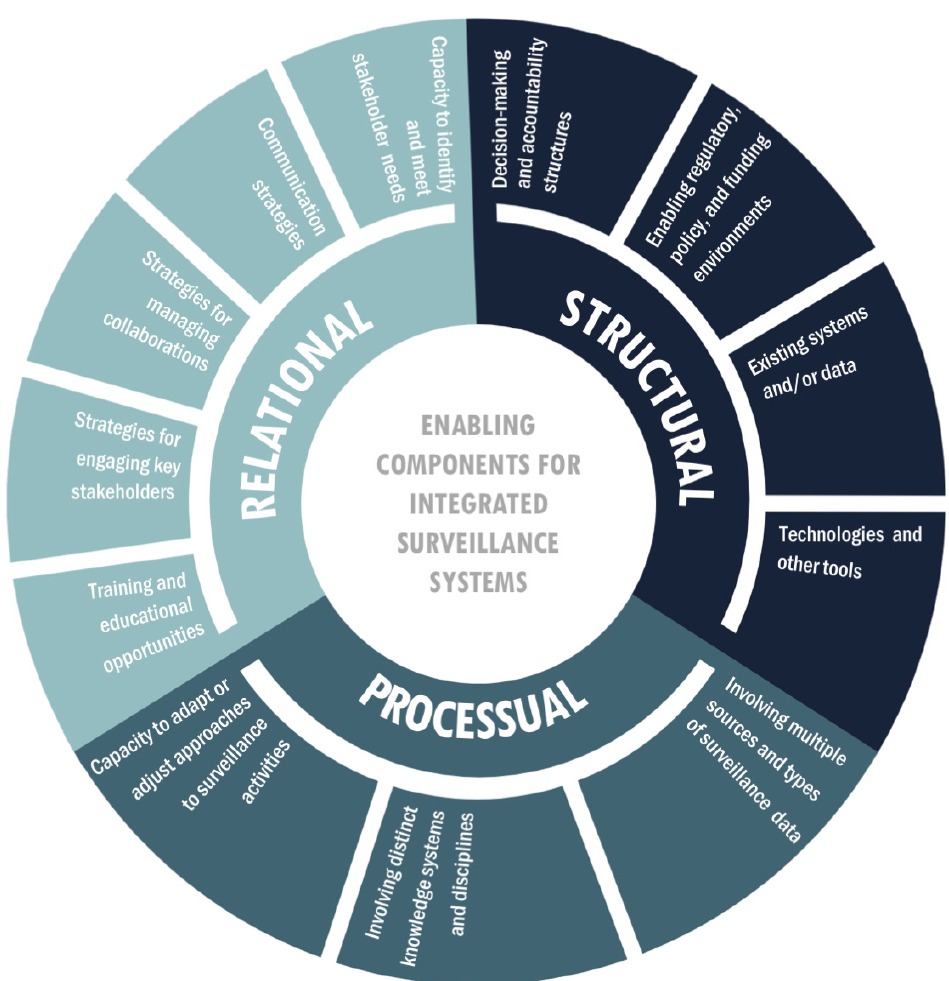
Figure 6. A visual display of the relationship between structural, relational, and processual components that enhanced and enabled attributes and activities of integrated environment and health surveillance systems in Circumpolar Arctic and Subarctic regions, as represented in the literature.